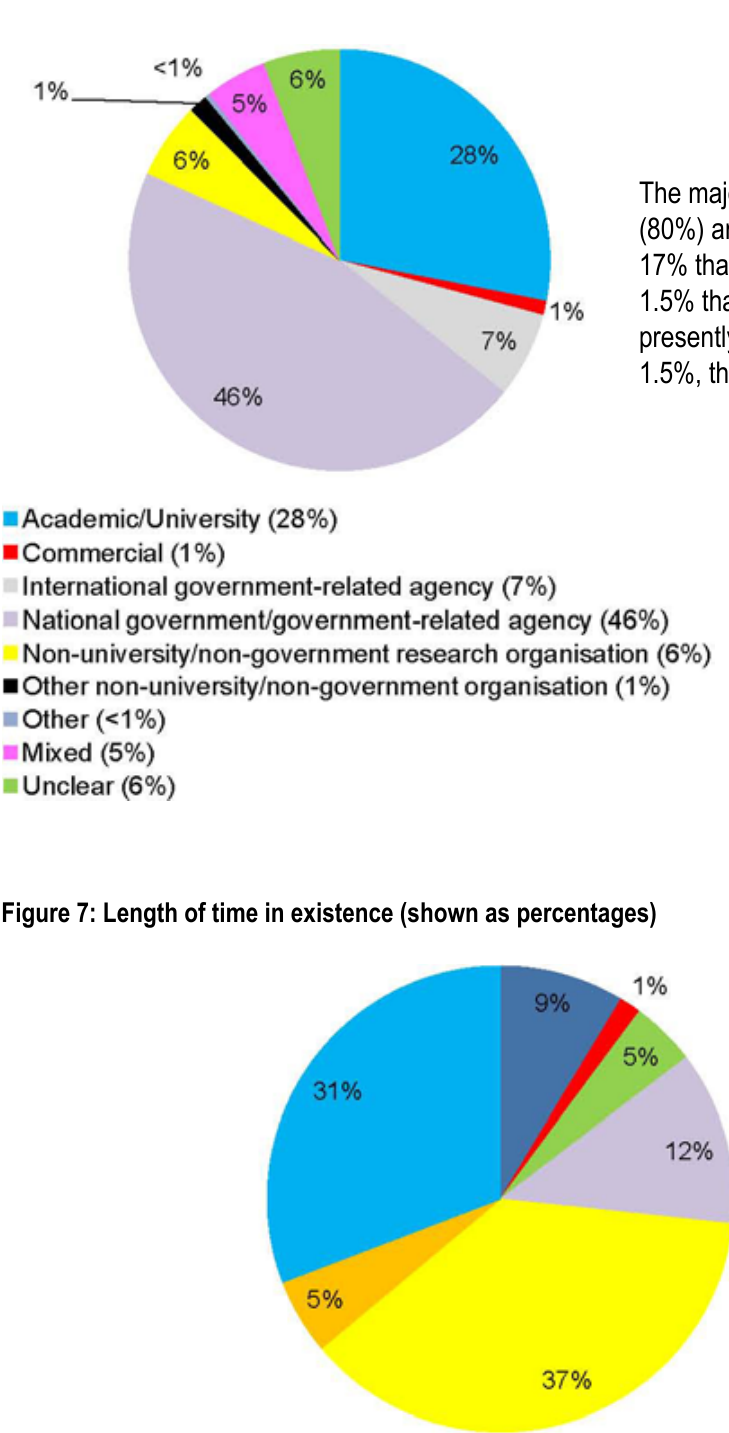
Figure 6: Type of organisation responsible for managing the activity (shown as percentages)